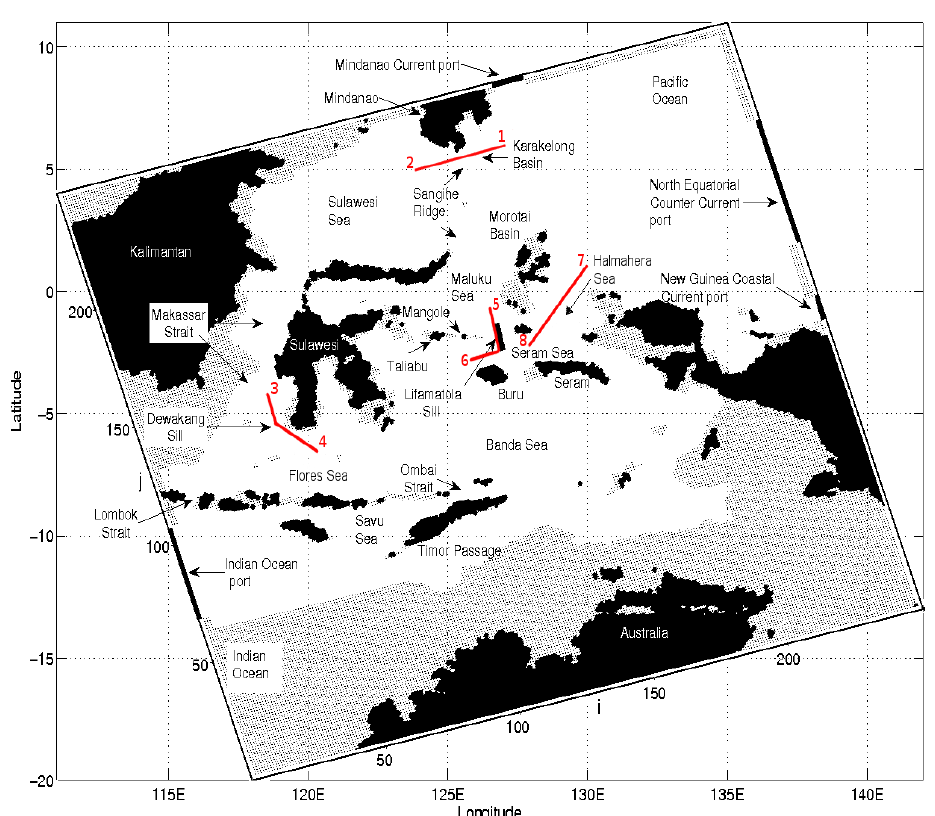
Fig. 1. The model domain location along with names of important topographic features and open ports. The model domain was rotated relative to lines of constant lat.–long. so that the Indian Ocean port was located on the JADE (Java-Australia Dynamics Experiment) Au- gust 1989 CTD (conductivity, temperature, depth) transect between northwestern Australia and Bali. The model (x,y) domain ranges between i and j values of 1 to 250 (see i,j values along model domain edge). Model domain corners in lat.–long. values are as follows: SW: 20 ◦ S, 118 ◦ E; SE: 13 ◦ S, 142 ◦ E; NE: 11 ◦ N, 135 ◦ E; and NW: 4 ◦ N, 111 ◦ E. The 4 open ports are shown as bold lines along the edge of the model domain. The depth in the grey (dotted) region is less than 100m. However, the grey region in the Indian Ocean in the southwestern corner of the model domain is greater than 100 m but has been excluded from the model integration to facilitate the Indian Ocean open port. The red lines show locations of the sections through the North Sangihe Ridge (1–2), the Dewakang Sill (3–4), the Lifamatola Sill (5–6), and the Halmahera Sea (7–8), discussed in Sect. 3. The thick black line through the Lifamatola Sill in the north–south direction shows the location of the profiles discussed in Sect. 4.